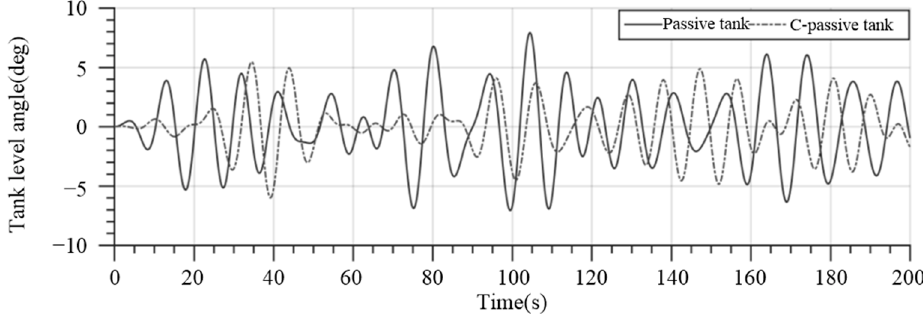
Figure 13. Tank level angle of passive anti-rolling tank and controllable passive anti-rolling tank.